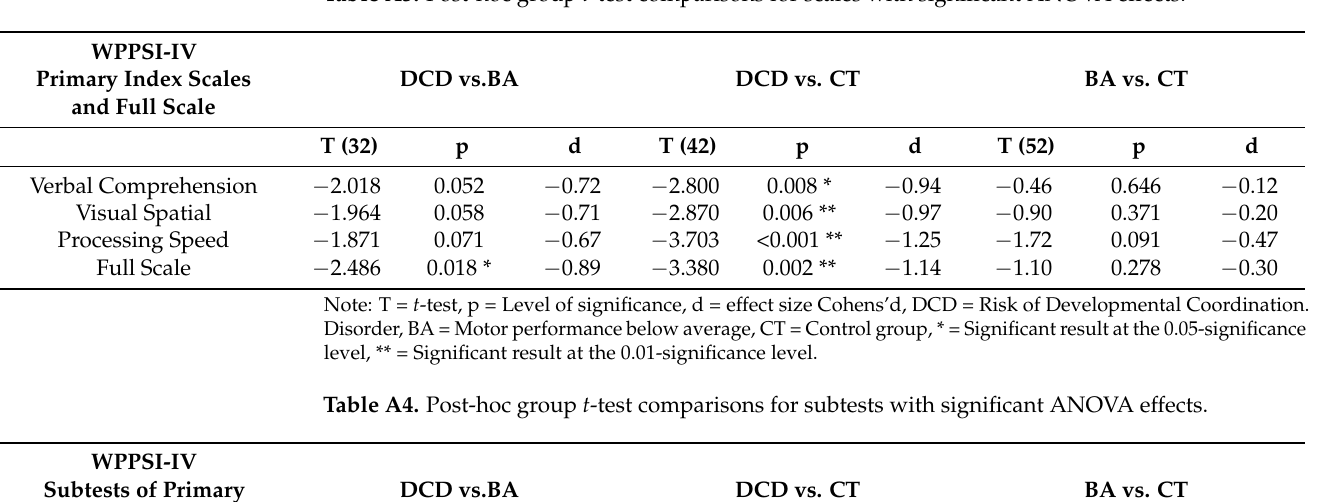
Table A3. Post-hoc group t -test comparisons for scales with significant ANOVA effects.